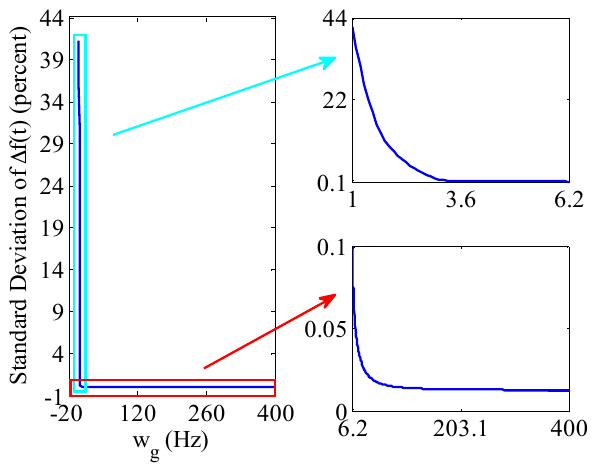
Figure 15. Impact of w g on spin rate accuracy extracted by the BCZT. The top right figure is a local enlarged drawing of spin rate accuracy varying with w g from 1 to 6.2 Hz. The bottom right figure is a local enlarged drawing of spin rate accuracy varying with w g from 6.2 to 400 Hz.